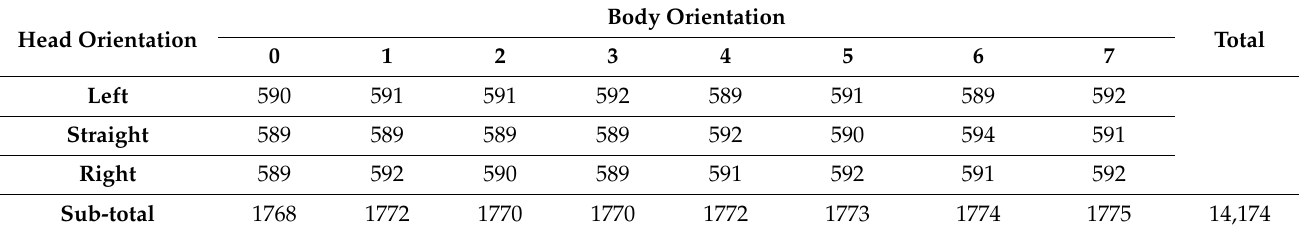
Table 1. Number of frames in dataset for joined body and head orientation.